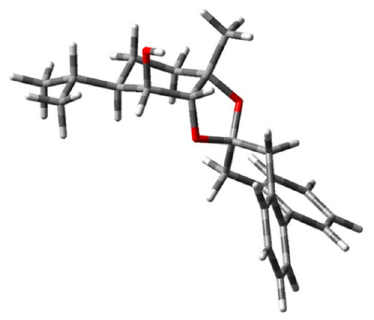
Figure 6. The most stable conformer (DFT/B3LYP/TZVP/IEFPCM(CH 3 CN)) of (1 S ,2 R ,3 S ,4 R )- 3 . The structure atoms are coloured as follow: carbon (grey), hydrogen (light grey), oxygen (red).